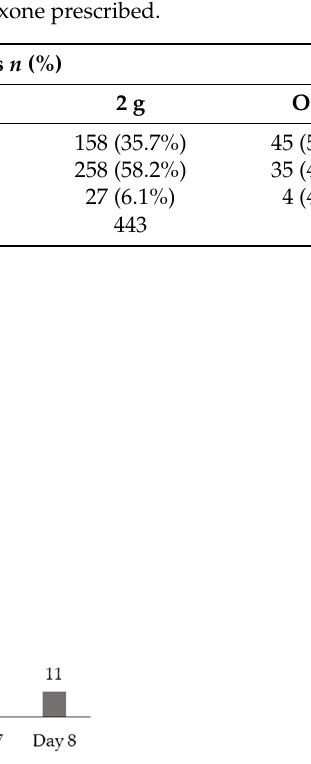
Figure 3. Doses of ceftriaxone that were missed during the administration of prescribed doses. One or more potential drug interactions with ceftriaxone were identified on the prescriptions reviewed for eight out of the nine health facilities. The overall